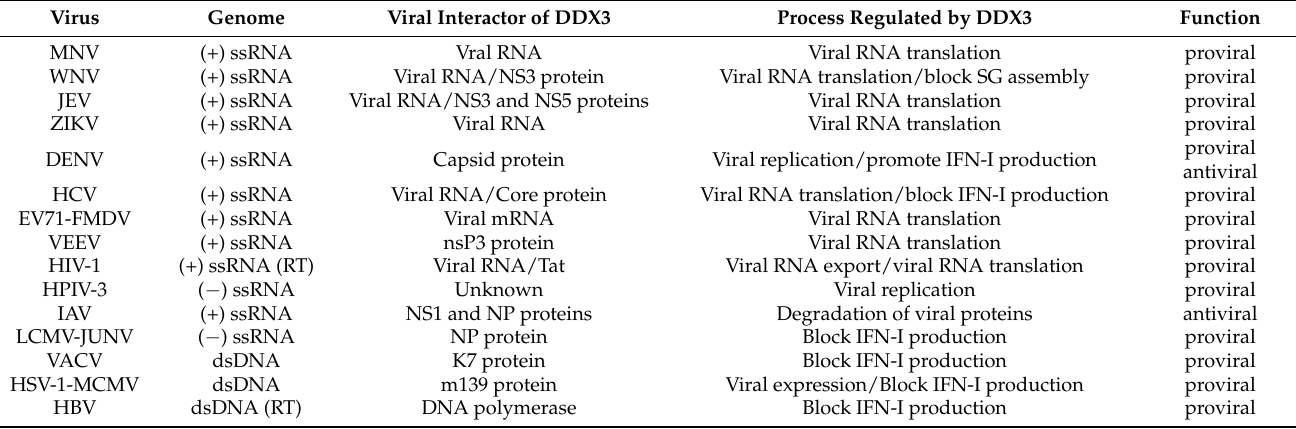
Table 1. Summary of the interactions between DDX3 and